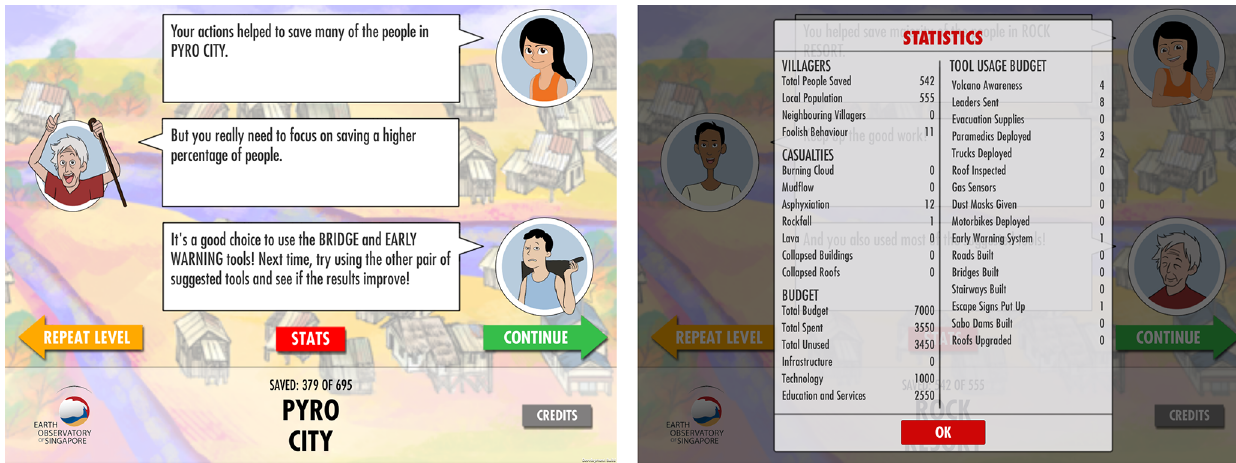
Figure 14. Players can review general feedback on their performance and strategic choices (left) as well as gameplay statistics